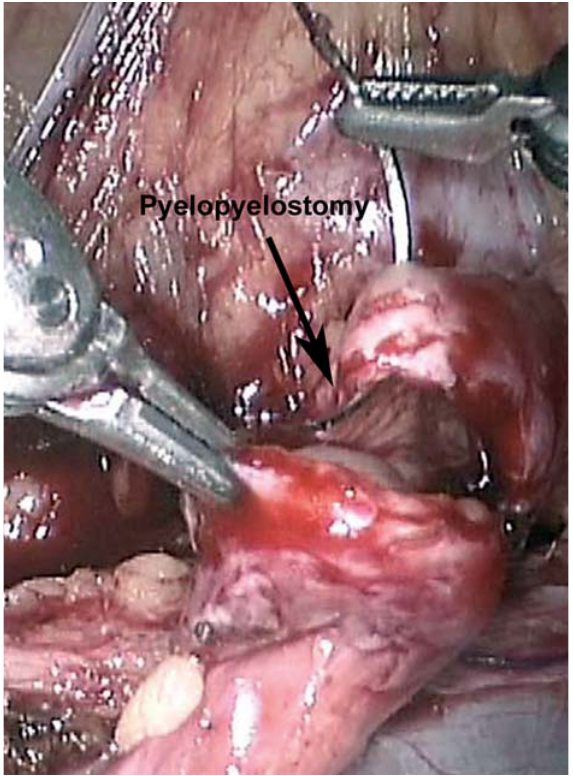
Figure 7 – Antegrade JJ stent insertion.